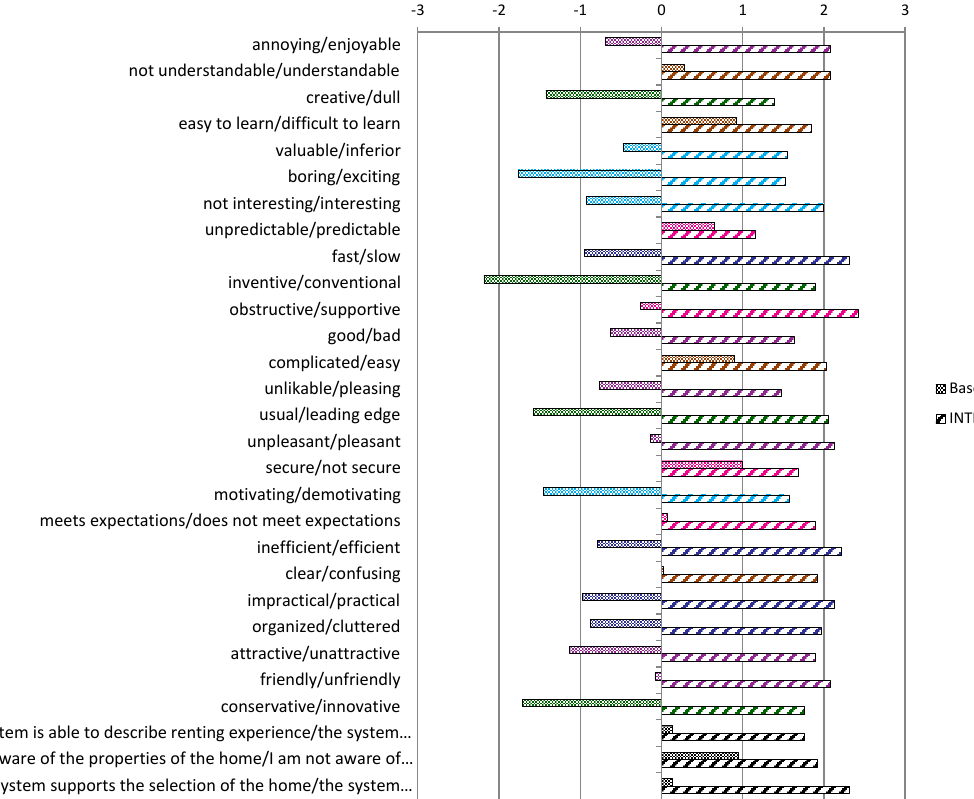
Figure 5. Post-task questionnaire results with items sorted as in the administered survey. The histogram shows the comparison of Baseline and INTEREST models on individual UX aspects. The colors of each bar represents the UX factor to which the bipolar item belongs, see Table 3 for color